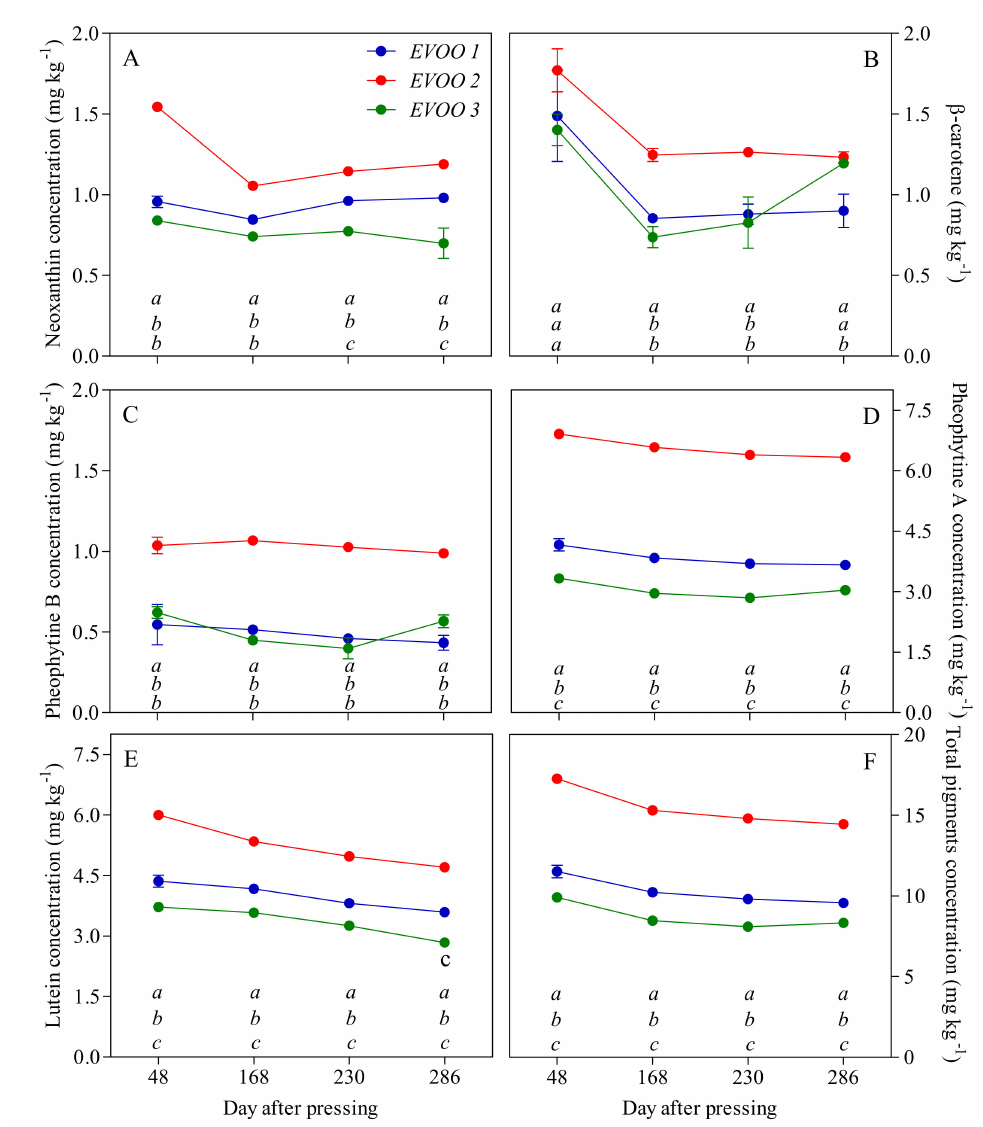
Figure 4. Pigment concentrations (mg kg − 1 ) in EVOOs at di ff erent times of storage (days after pressing). ( A ) Neoxanthin; ( B ) β -carotene; ( C ) Pheophytin B; ( D ) Pheophytin A; ( E ) Lutein; ( F ) Total pigments concentrations. For each sampling data, di ff erent letters indicate significant di ff erences among EVOOs. One-way ANOVA (Bonferroni post-test correction, p <